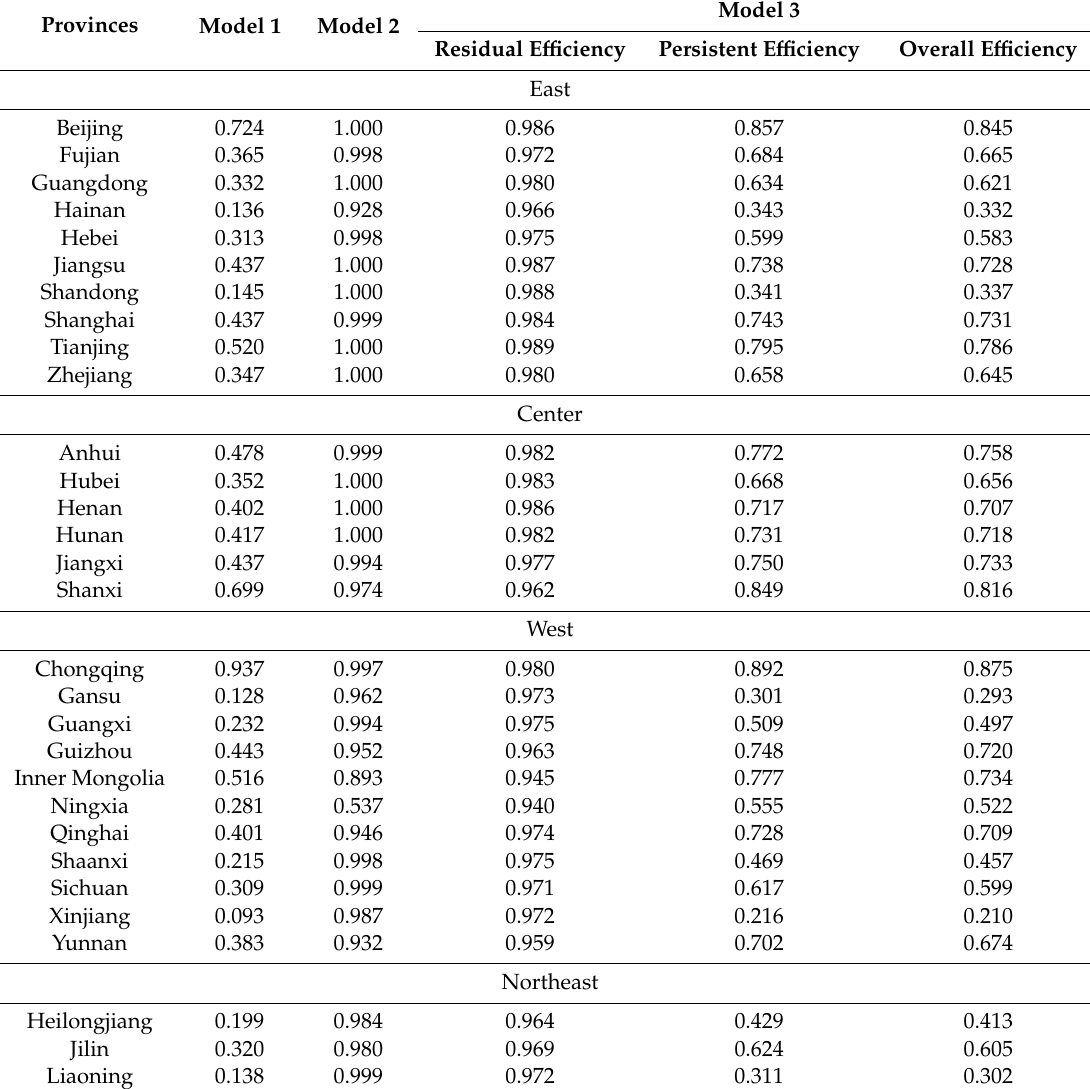
Table 7. Average energy use e ffi ciency by provinces